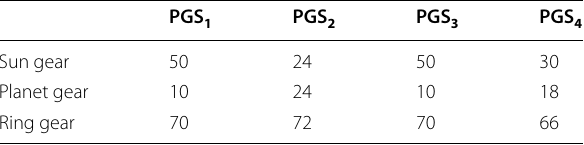
Table 14 Teeth number of gears in the PGSs